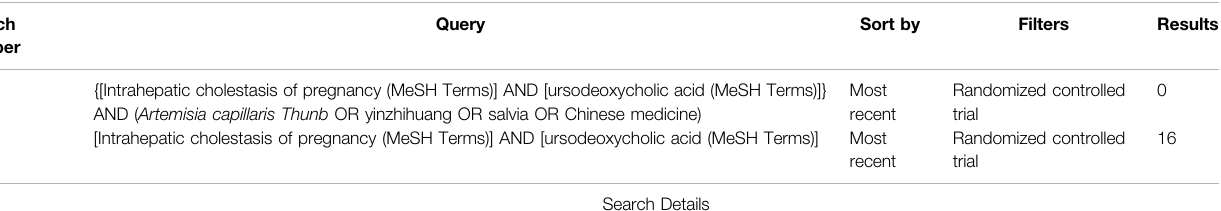
TABLE 1 | Search strategy in PubMed.